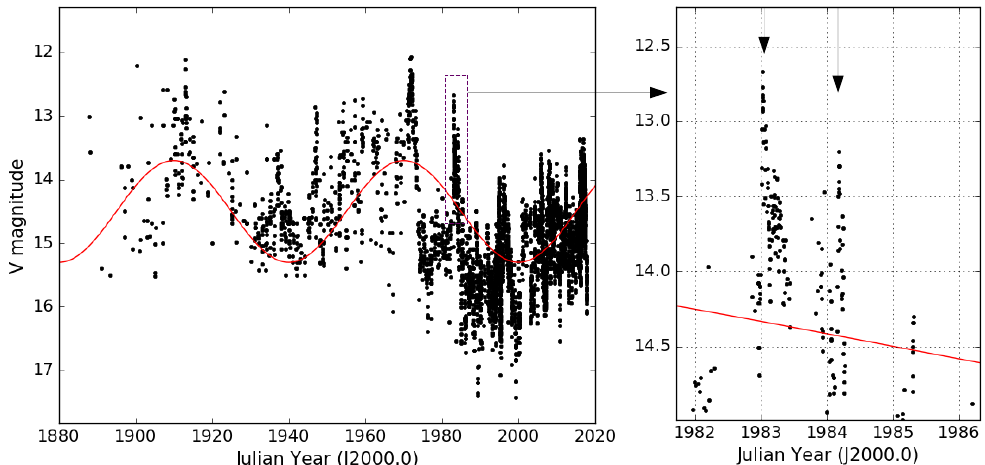
Figure 1. The left panel shows the optical LC of OJ 287 from 1888 to 2018. The red sinusoidal curve helps to visualize the longer 60 year periodicity in the LC. The right panel focuses on the LC from 1982 to 1986 for demonstrating the doubly peaked nature of these outbursts